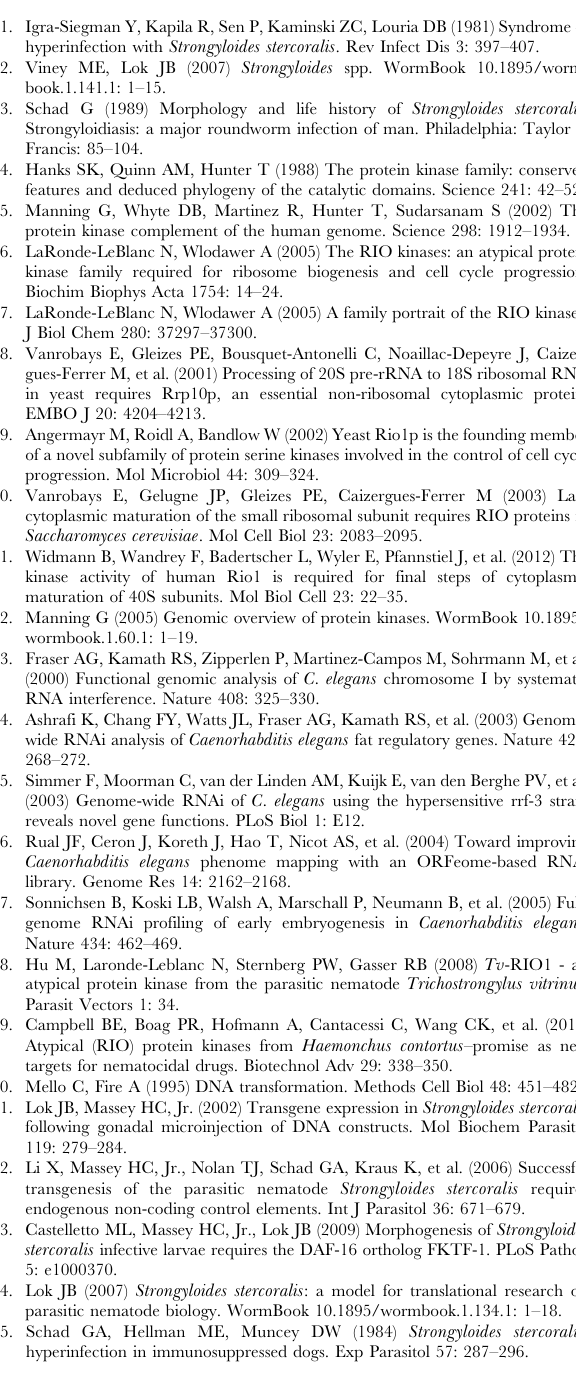
Table S1 The names and DNA sequences of primers used in the present study for isolating cDNA and promoter region of Ss-riok-1 and for constructing pro- tein expression and transgenic